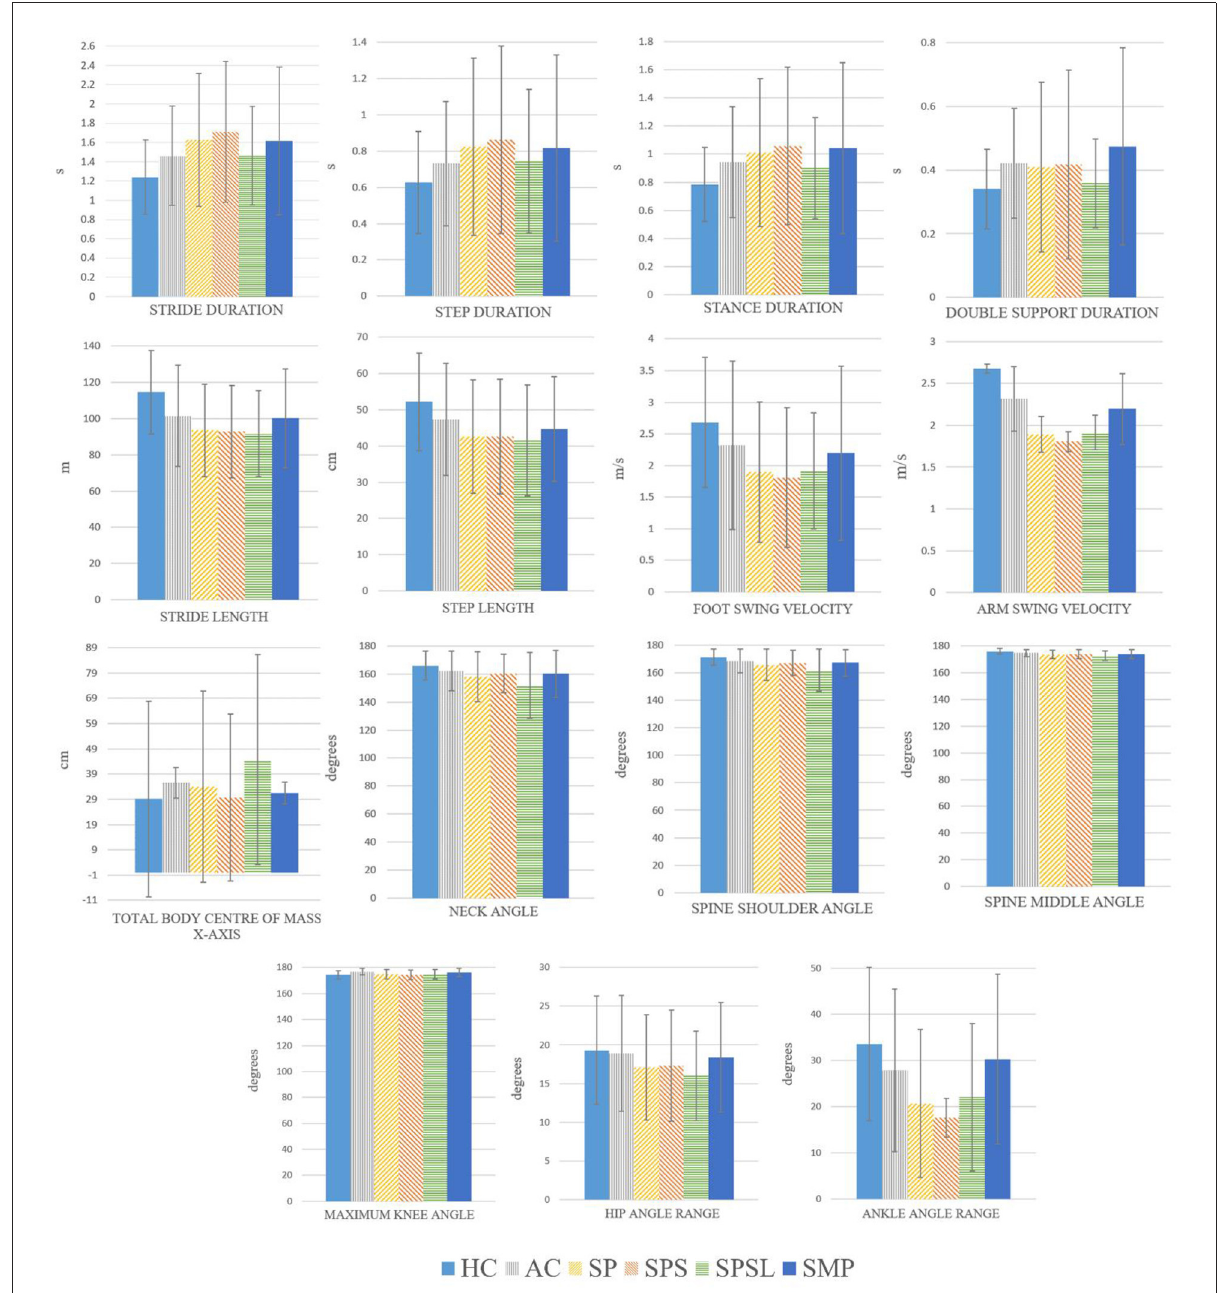
FIGURE3 Mean and standard deviation for each subject group, for the gait parameters that showed statistically significant differences in the Conover-Iman test (p ≤ 0.05) for all the comparisons, when comparing different pairwise comparison, included in Table III, between the six groups (HC, AC, SP, SPS, SPSL and